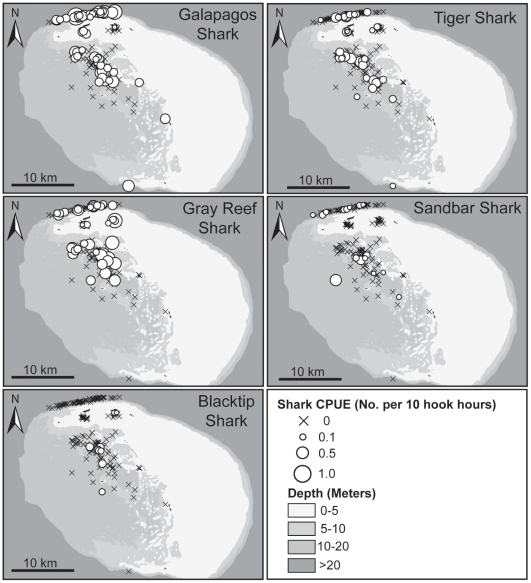
Spatial distribution of longline Catch Per Unit Effort (CPUE).In all panels, scaled circles indicate CPUE >0, crosses indicate CPUE  = 0. CPUE  =  sharks per 10 hook hours.